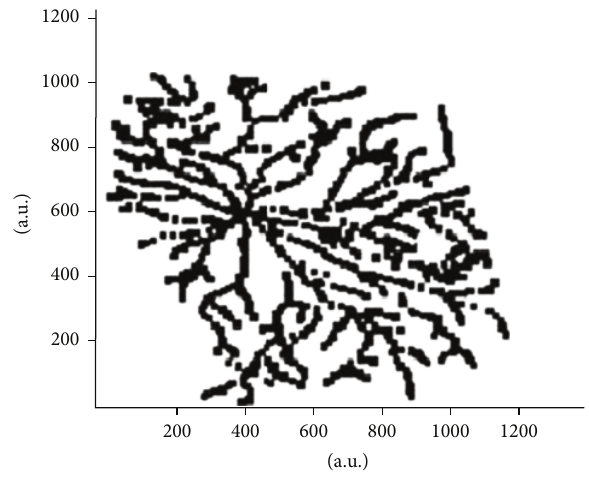
Figure 2: Extracted image of the real pattern.